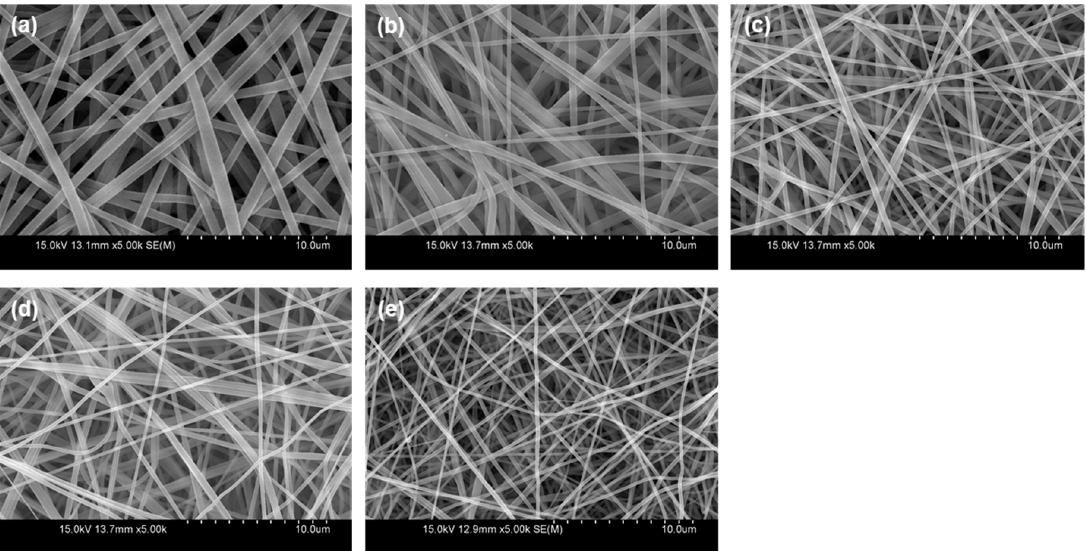
Figure 3. FE-SEM images (5000×) of 30% (w/v) PES nanofibers with different LiCl concentrations at each optimal voltage, the feed rate of 0.5 mL/h, and the tip-to-collector distance of 20 cm. ( a ) 0% optimal voltage, the feed rate of 0.5 mL / h, and the tip-to-collector distance of 20 cm. ( a ) 0% ( w / v ) / 13.0 kV, Appl. Sci. 2020 , 10 , x FOR PEER REVIEW (w/v)/13.0 kV, ( b ) 0.01% (w/v)/15.5 kV, ( c ) 0.03% (w/v)/17.5 kV, ( d ) 0.05% (w/v)/19.5 kV, ( e ) 0.10% ( b ) 0.01% ( w / v ) / 15.5 kV, ( c ) 0.03% ( w / v ) / 17.5 kV, ( d ) 0.05% ( w / v ) / 19.5 kV, ( e ) 0.10% ( w / v ) / 22.0 kV. (w/v)/22.0 kV.